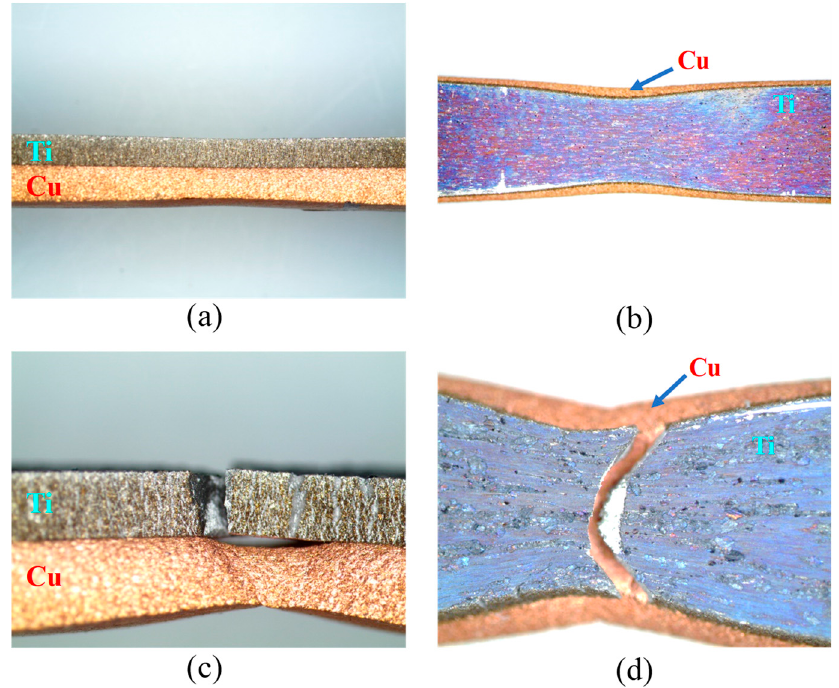
Figure 6. Top-view and side-view of the titanium clad during the tensile test: ( a , b ) 1 h and ( c , d ) 2 h; ( a , c ) side-view and ( b , d ) top-view.